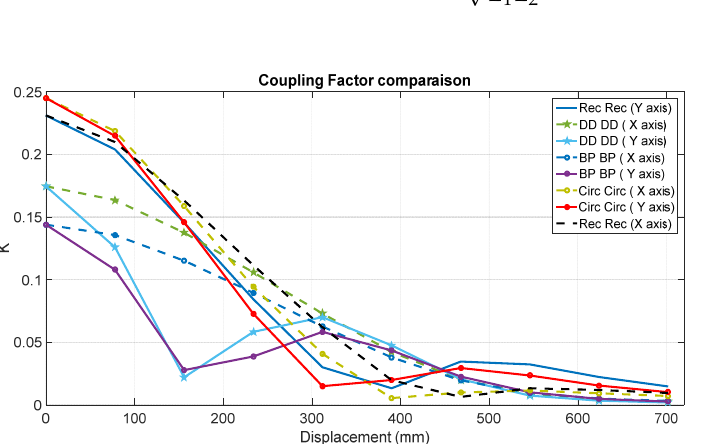
Figure 12. Coupling factor for different displacement positions.